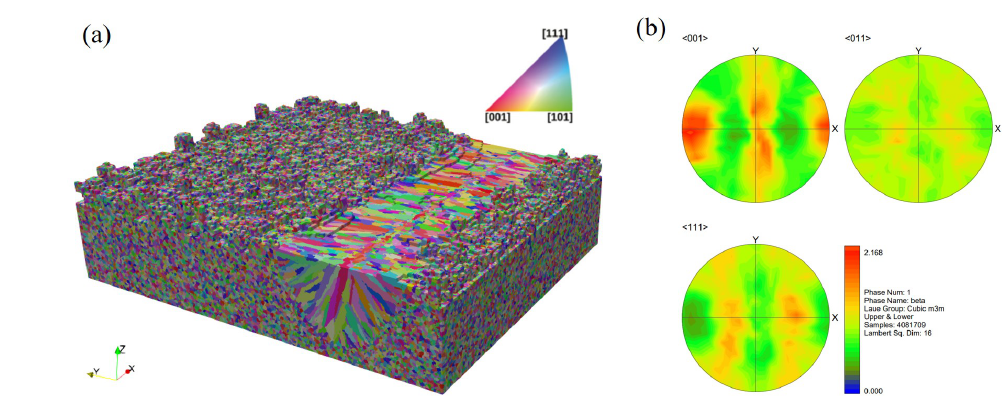
Figure 8. Microstructure simulation results for Case P180V63: ( a ) 3D view, ( b ) pole figures (PF) of the solidification grain structure within the fusion zone.